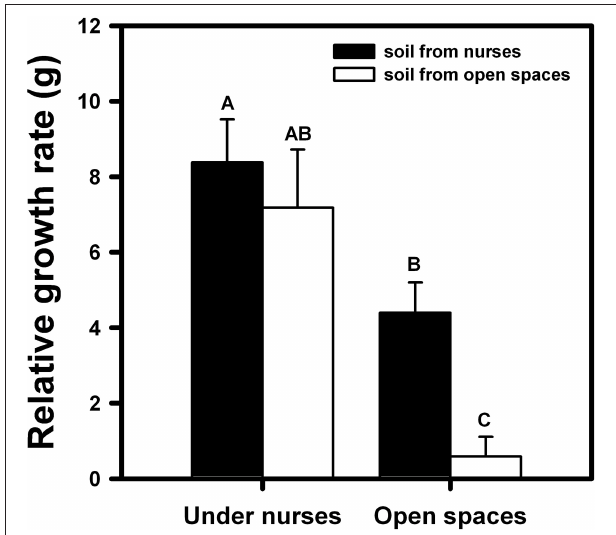
FIGURE 2 | Relative growth of B. fimbriata rosettes under the four different treatments in the field: under nurse canopy + soil from nurses (NN), under nurse canopy + soil from open spaces (NO), in open spaces + soil from nurses (ON) and in open spaces + soil from open spaces (OO). Different letter indicates significant differences. Bars are means ± SE. Different letters indicate significant